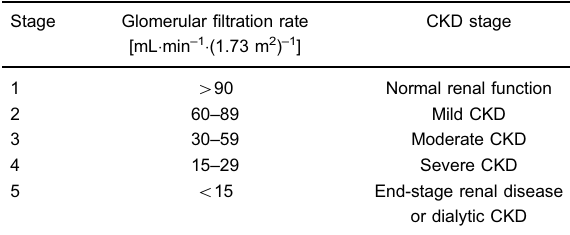
Table 1. Chronic kidney disease (CKD) stages according to glomerular fi ltration rate. Stage Glomerular fi ltration